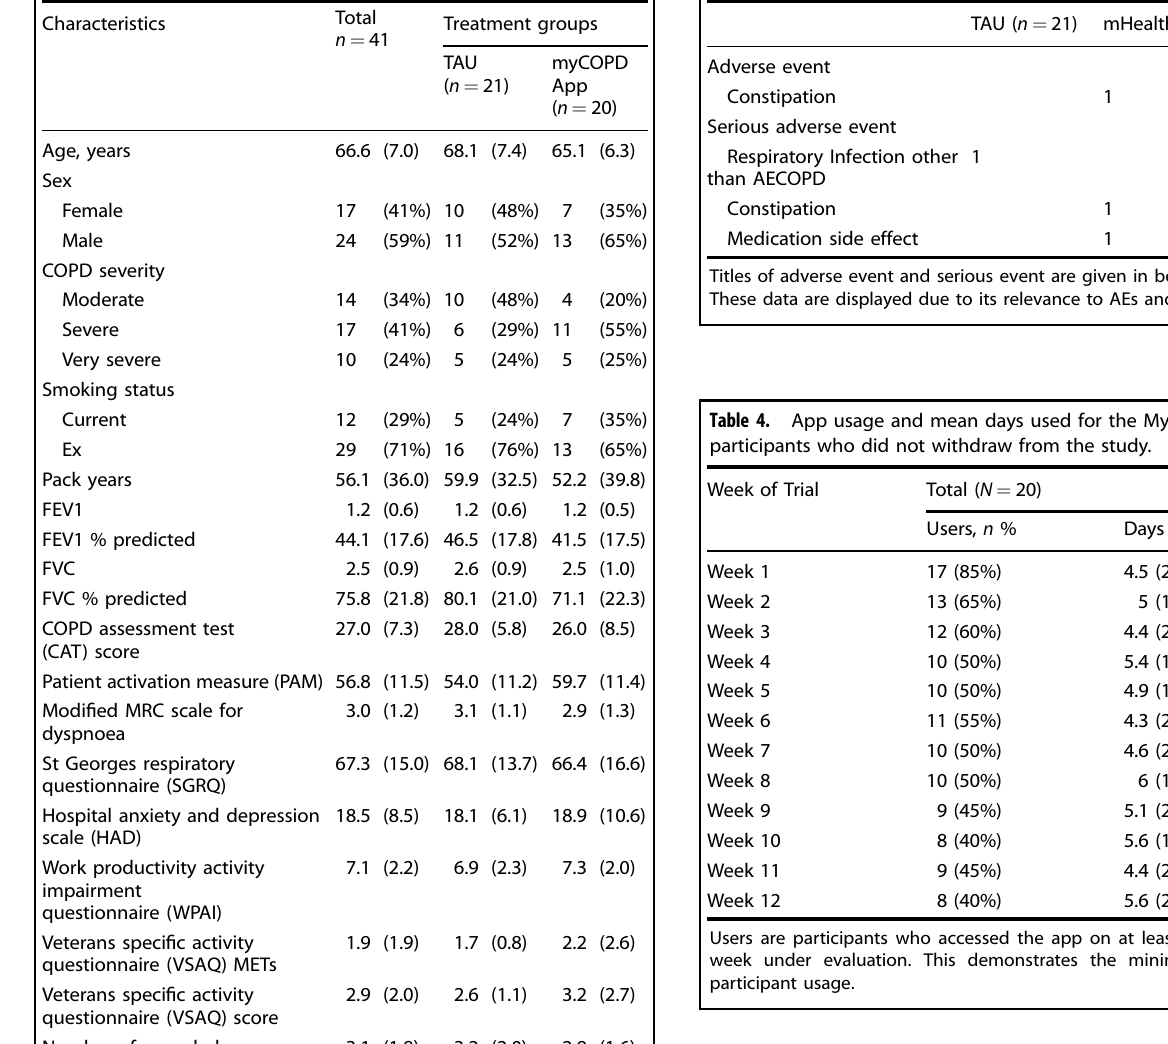
Table 3. Safety-adverse and severe adverse events.